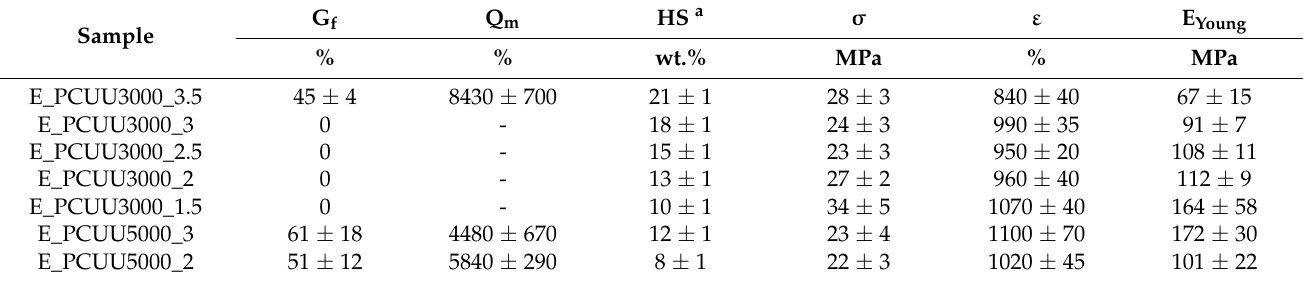
Table 2. Hard segment content (HS), swelling behavior, and mechanical properties of PCUU